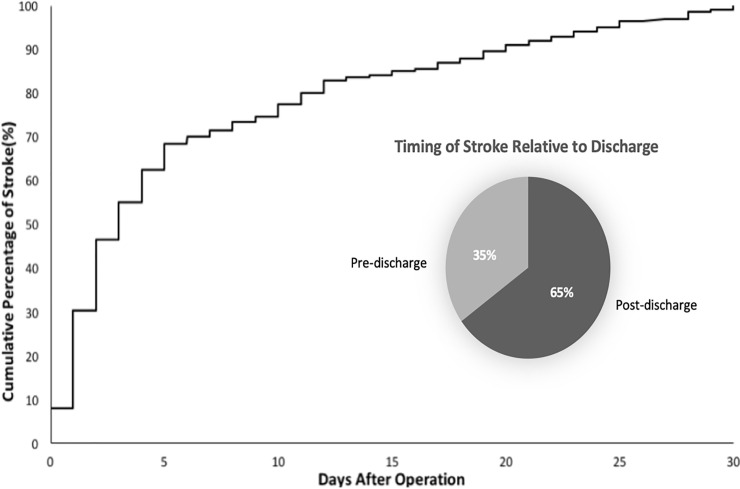
Cumulative percentage of stroke 30 days post-operation.